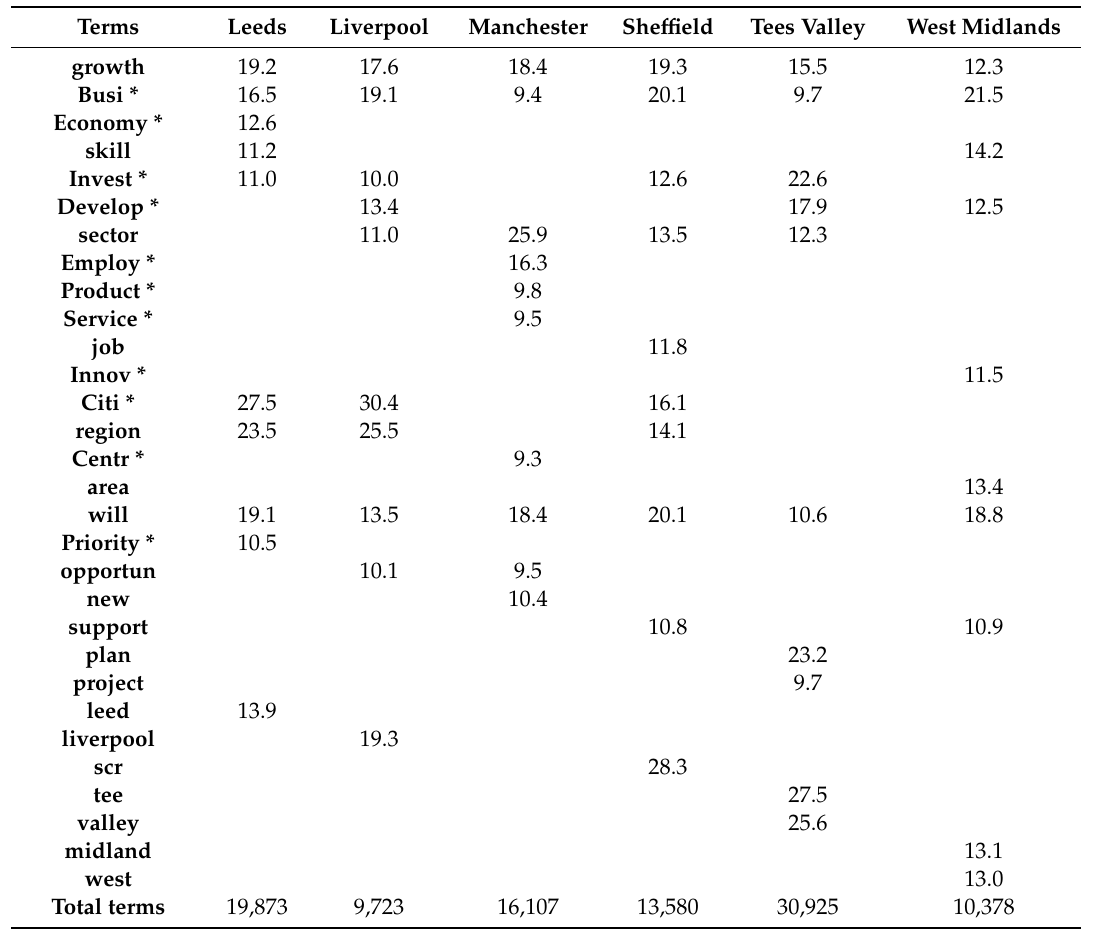
Table 2. Scaled frequency of the 10 most over-represented terms in each document. Only the 10 most frequent words are reported for each document, although two documents can have the same terms in their top 10. We use scaled frequency to compare the frequency of terms relative to the average and dispersion of frequencies of each document. * Terms have been reduced to their root